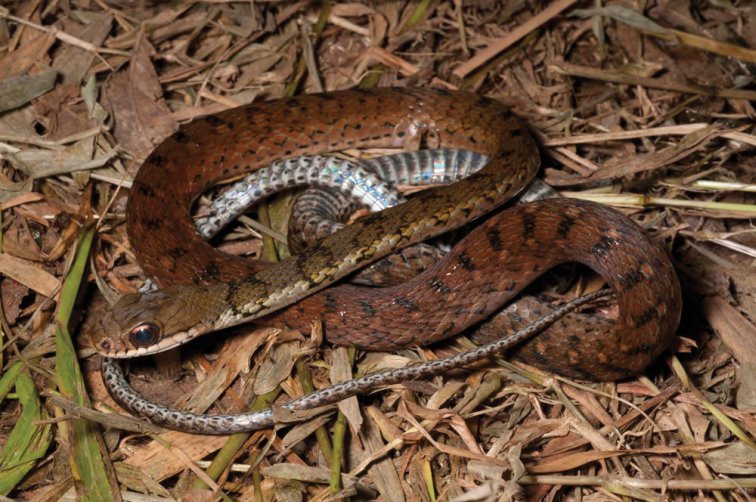
Tropidonophis dendrophiops (KU 330031) from mid-elevation, Mt. Cagua, Location 1b. Photo: RMB.